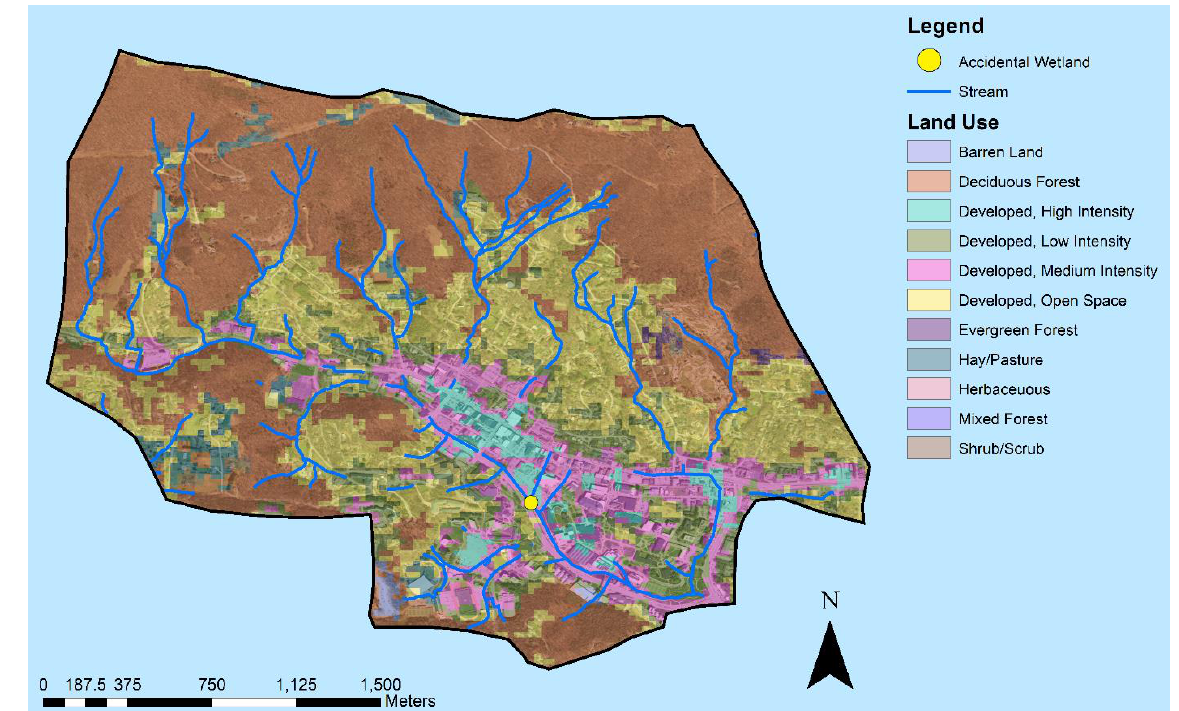
Figure 2. Land use map of the Boone Creek watershed. The Accidental Wetland site is located in the light blue and pink regions, which designate medium and high intensity development, respectively. The stream includes culverted and nonculverted segments. The map was created using ArcGIS ® software by Esri, Redlands, CA, USA. Accessed on 10 February 2021. ArcGIS ® and ArcMap™ are the intellectual property of Esri and are used herein under license. Copyright © Esri. All rights reserved. For more information about Esri ® software, please visit www.esri.com, accessed on 10 February 2021.